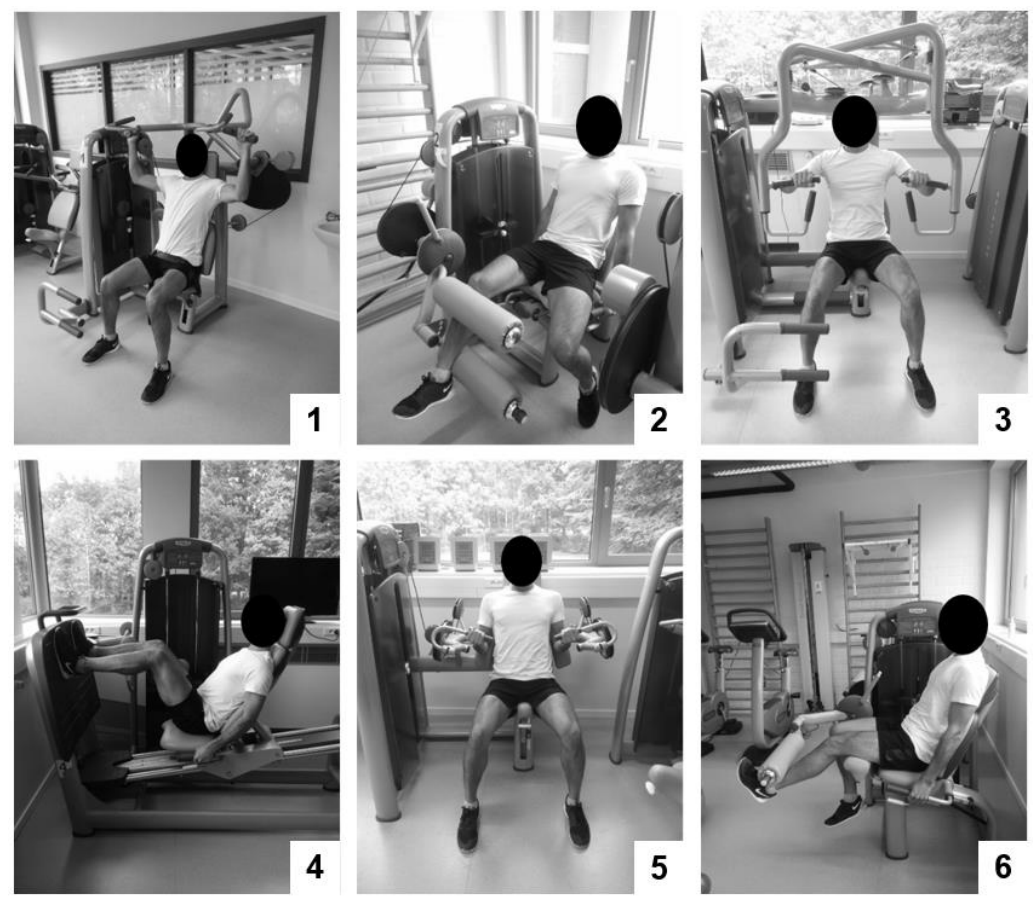
Figure 2. Strength exercises in the limb strength protocol: (1) vertical traction, (2) leg curl, (3) chest press, (4) leg press, (5) arm curl, and (6) leg extension.